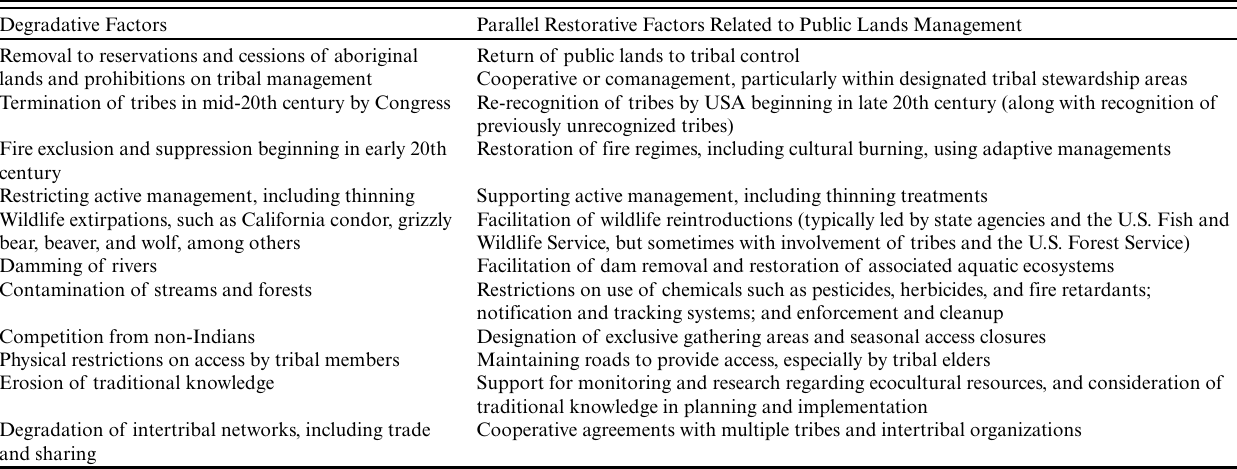
Table 1. Factors that have contributed toward a social-ecological trap paired with strategies to promote tribal well-being and sustainability, and recent examples from the Northwest Forest Plan area.